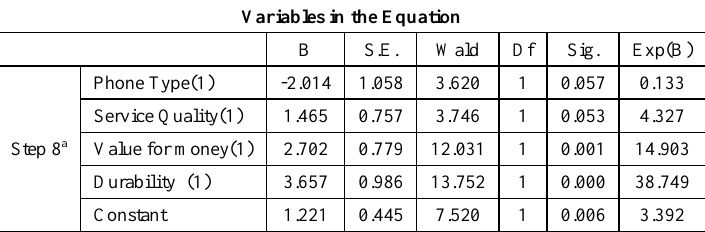
Table 4. Significant exogenous variables for logistic